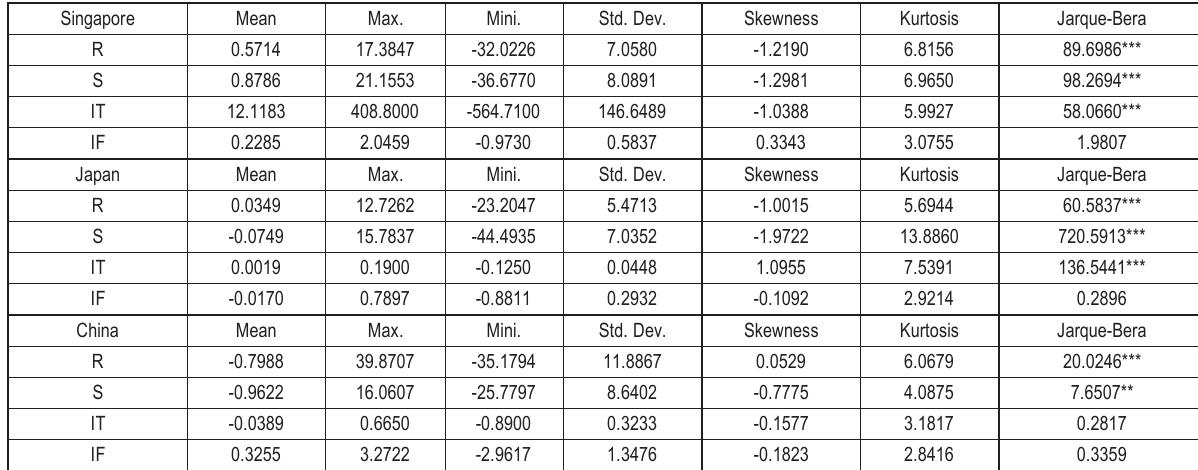
Table 2. Summary